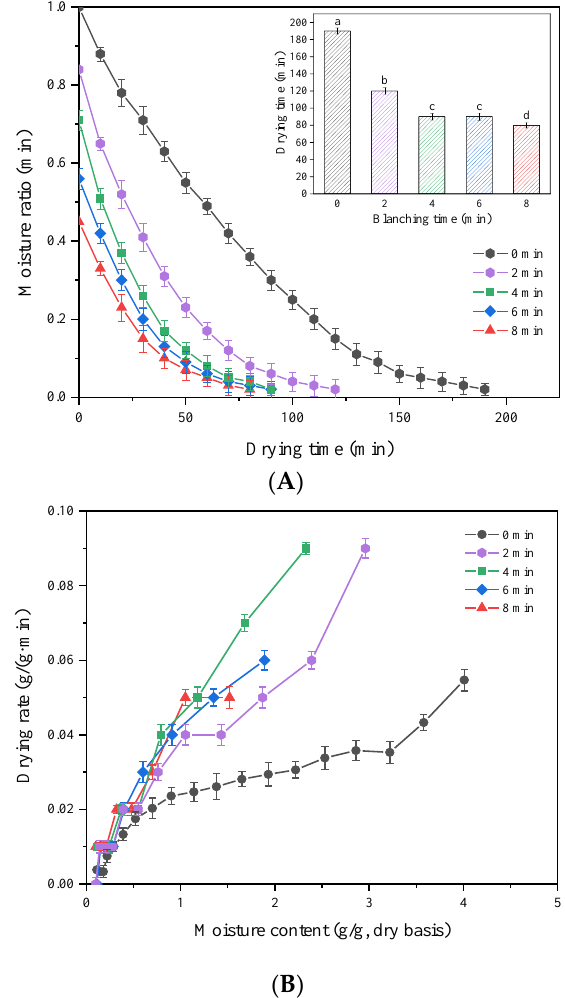
Figure 3. Moisture ratio ( A ) and drying rate curves ( B ) of A. sessiliflorus fruits with different blanching durations. Different letters indicate significant differences ( p < 0.05) according to the Duncan test.